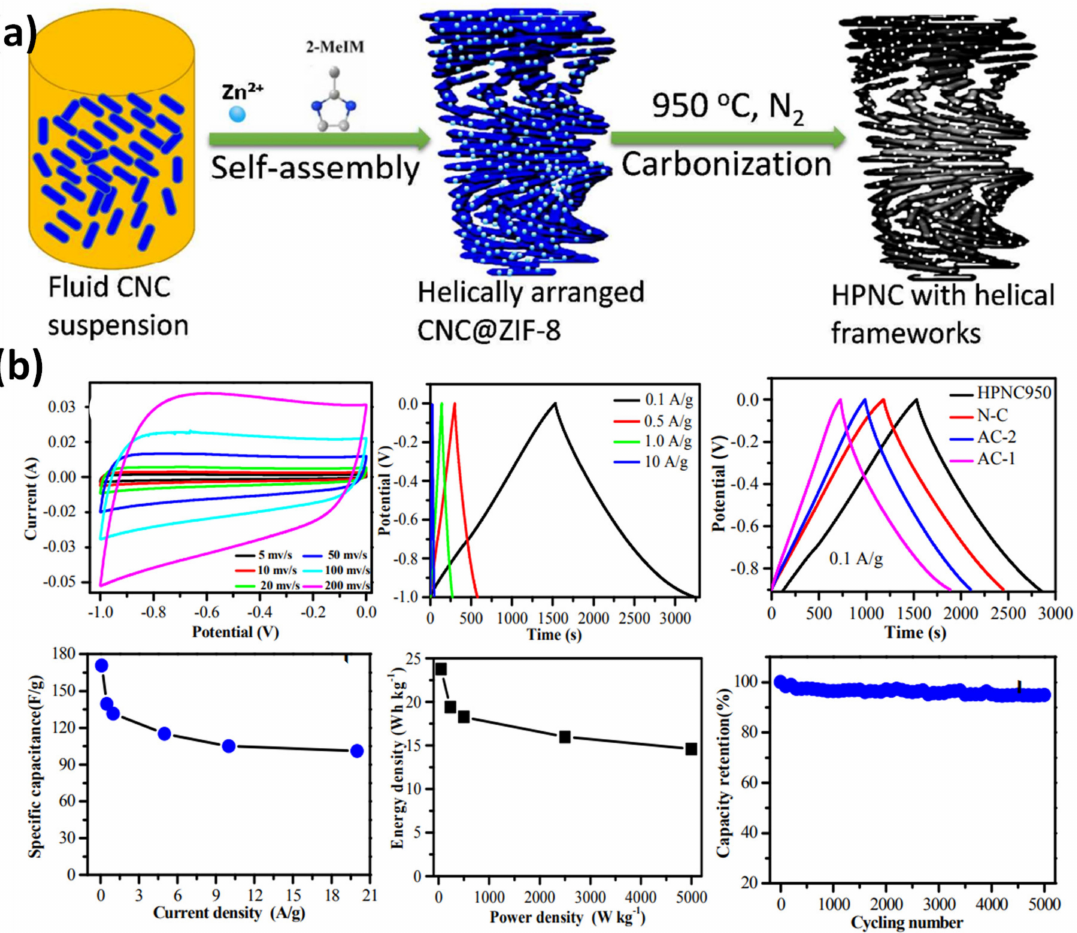
Figure 11. ( a ) Facile synthetic route of hierarchically porous N-doping carbon (HPNC), ( b ) Elec- trochemical characteristics of an HPNC composite in an aqueous KOH electrolyte. Adapted with permission from [121]. Copyright 2018 American Chemical Society